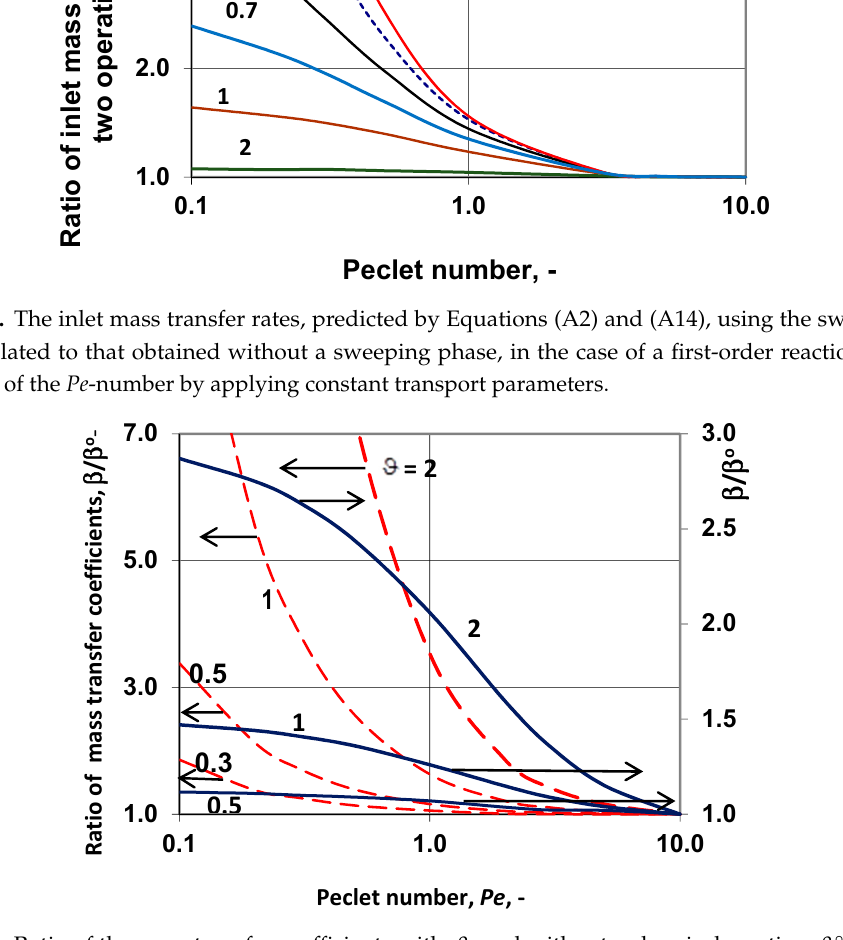
Figure 7. Ratio of the mass transfer coe ffi cients with, β , and without a chemical reaction, β ◦ , in the cases of both operation modes, namely with a sweeping phase (continuous lines; see Equations (14) and (A21) for β and β ◦ ) and without a sweeping phase (dotted lines; see Equations (14) and (A11) or β and β ◦ ).